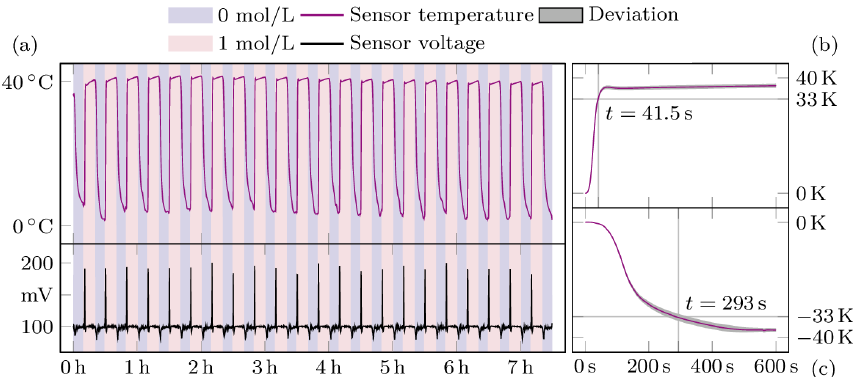
Figure 5. Measurement results of the sensor in compensation mode. Panel (a) shows both the temperature and voltage of the sensor through- out the experiment. In the background the concentration changes are shown in colour. On the right, panels (b) and (c) summarise the mean values of the individual